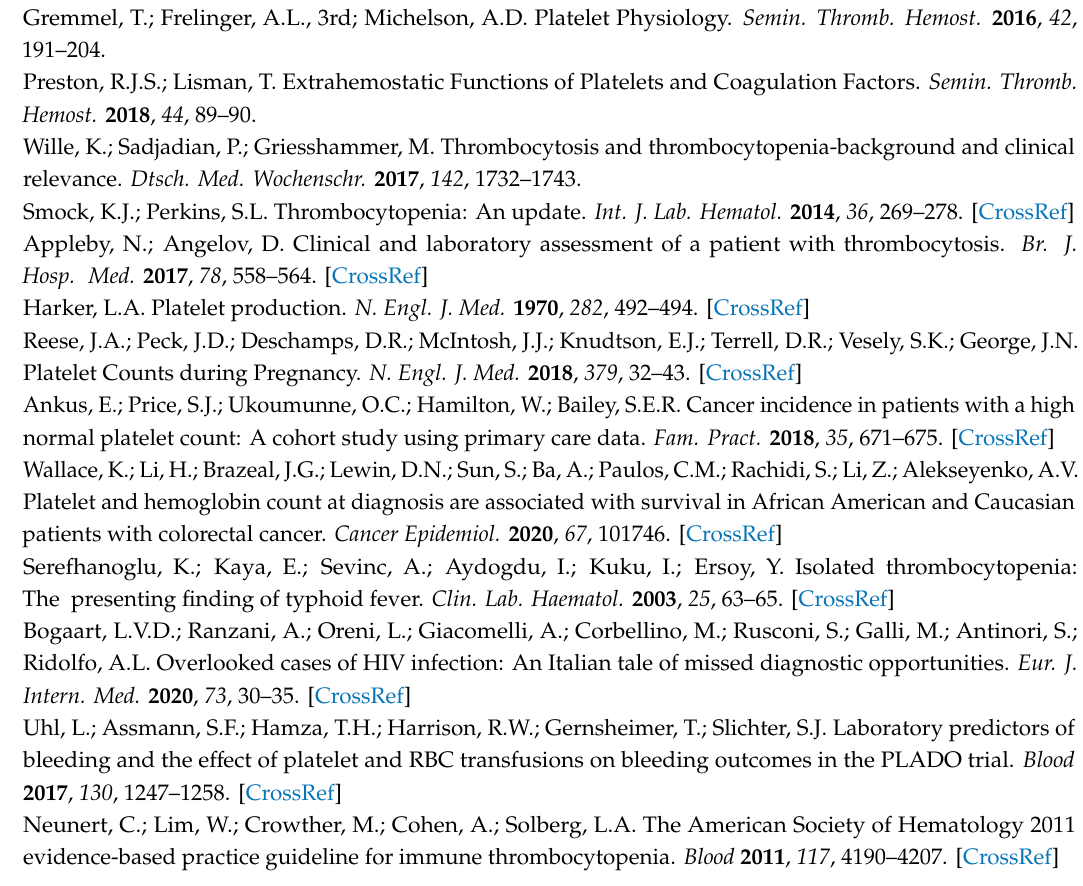
Figure S1: Platelet counts measured in Liechtenstein from 1 January 2013 to 31 December 2019, stratified by age and sex: results with di ff erent interpretation according to the employed reference